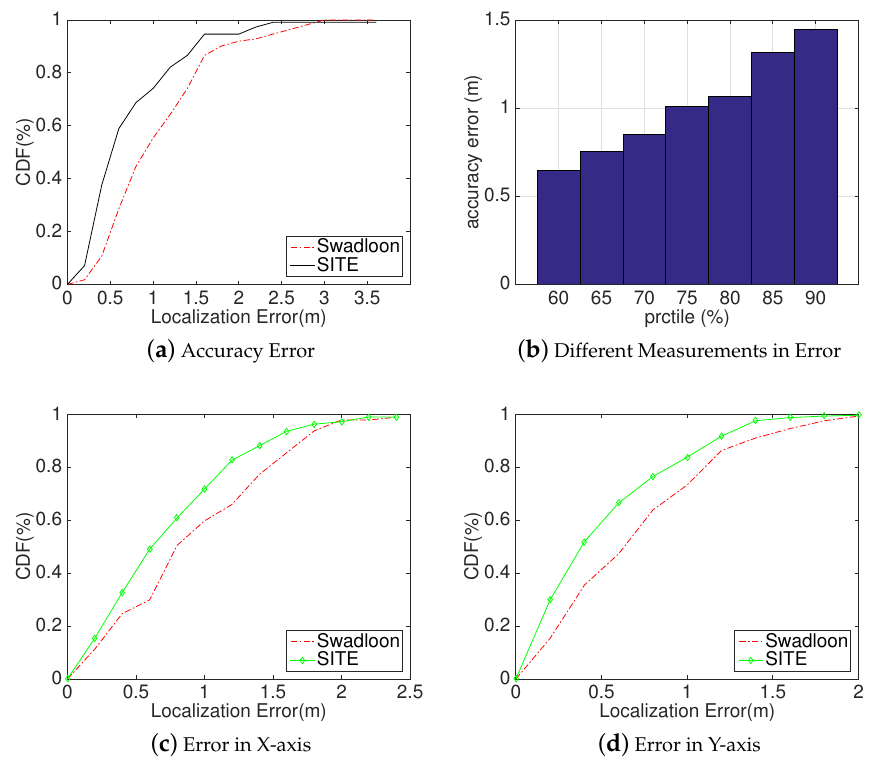
Figure 11. Evaluation Results in university’s library: ( a ) CDFs of localization error in library; ( b ) histogram of localization error in different percentile; ( c ) CDFs of localization error in X-axis; and ( d ) CDFs of localization error in